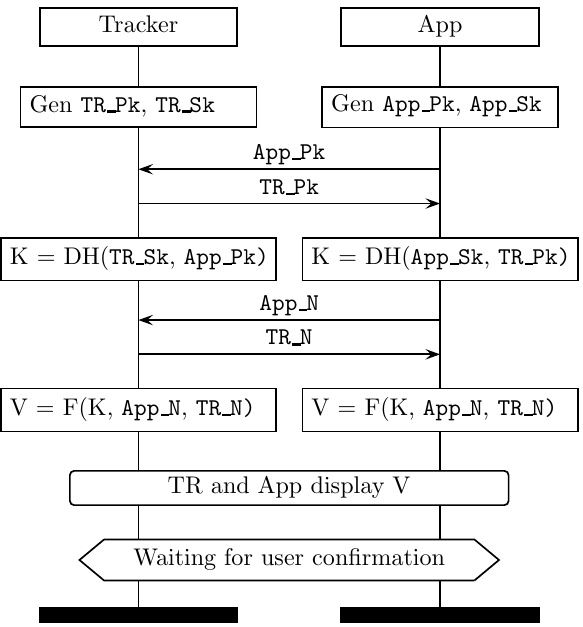
Figure 9: Authenticated key establishment (i.e., pairing) protocol providing